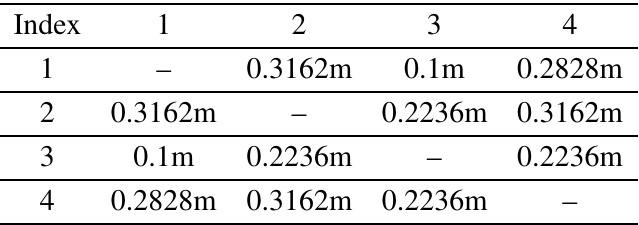
Table 2. Distance constraint between each two